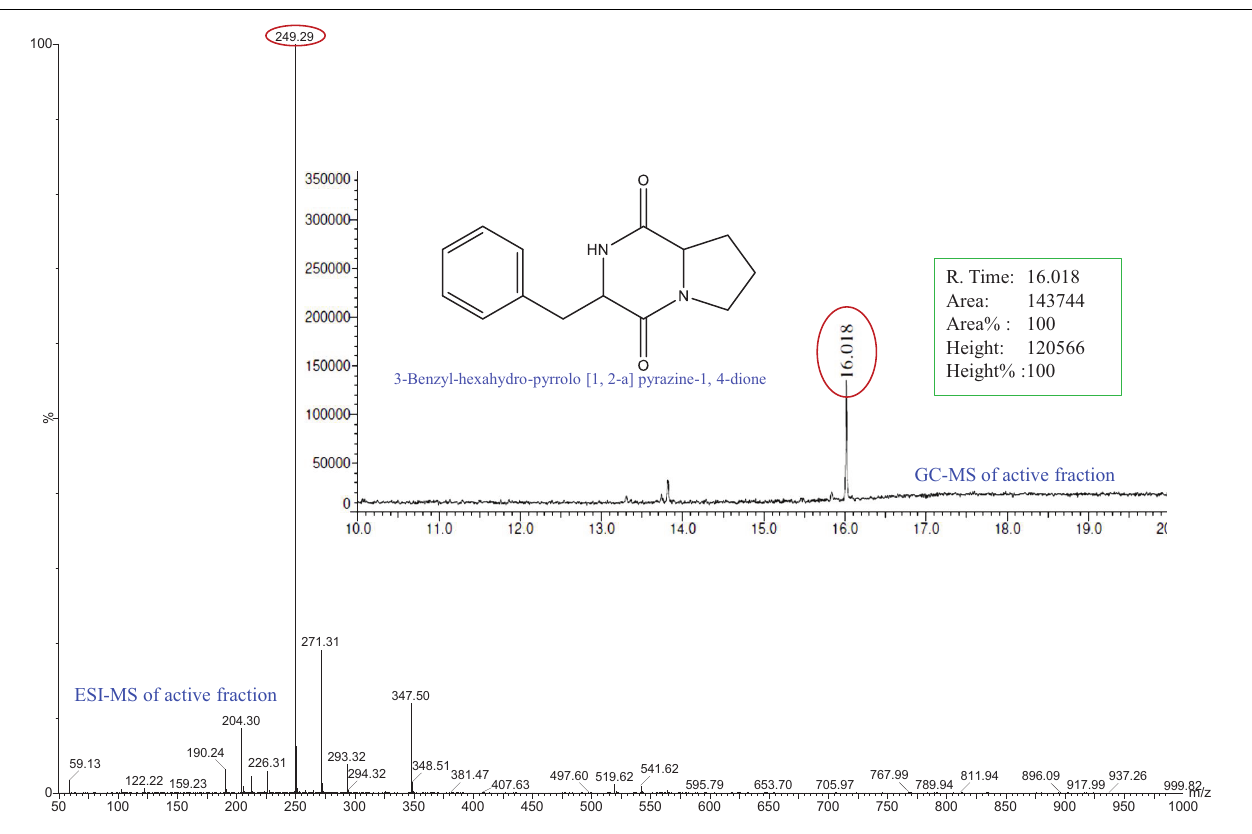
FIGURE 1 | Analysis of active fraction showing QSI. GC chromatograms and ESI-MS/MS of the active fraction (C18-40) of E. indicum SJ16 extract showed resemblance to 3-Benzyl-hexahydro-pyrrolo[1,2-a]pyrazine-1,4-dione (redrawn by ChemBioDraw Ultra 12.0).